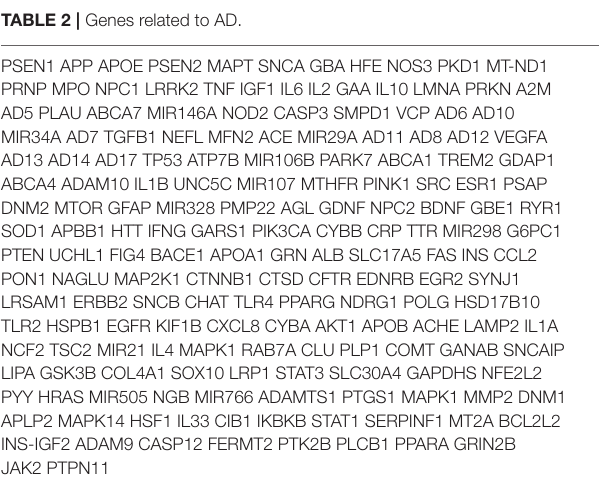
interaction score set as 0.4 and the isolated vertices removed ( Figure 1C ). The brightness, the bigger the dots are, the higher the degree is, representing the importance of the spot to the network.